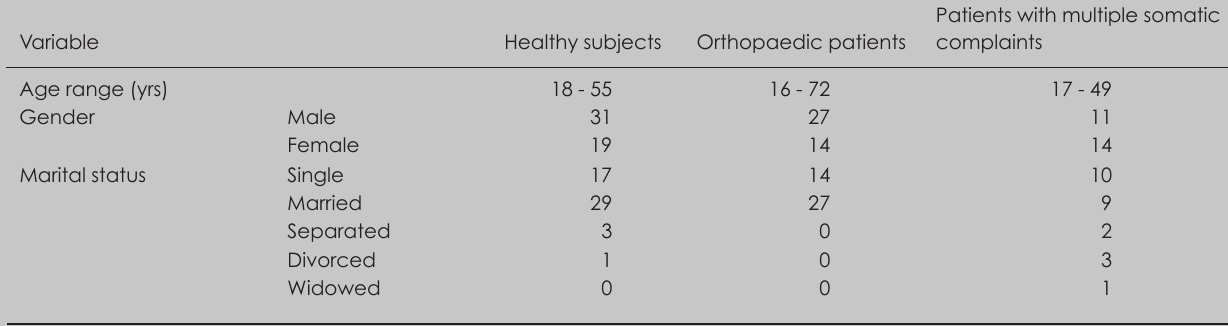
Table I. Socio-demographic characteristics of the subjects in the different groups